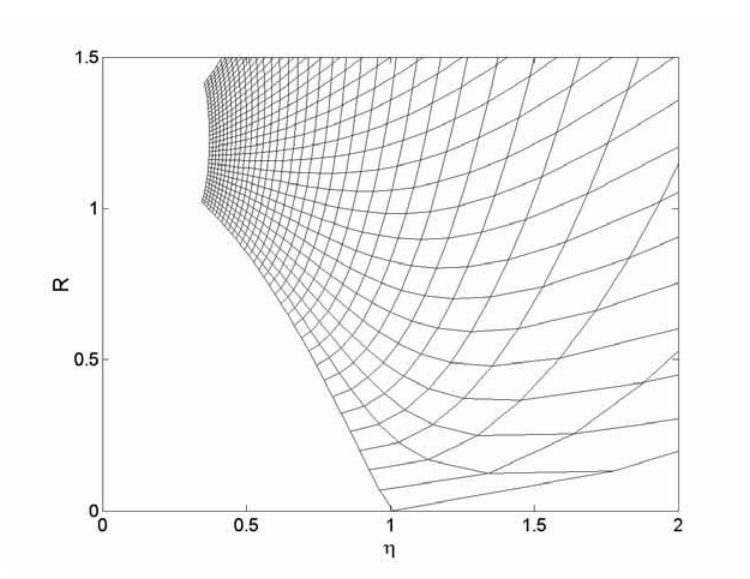
Fig. 16. Two-dimensional projection of the RMS surface to the R - η